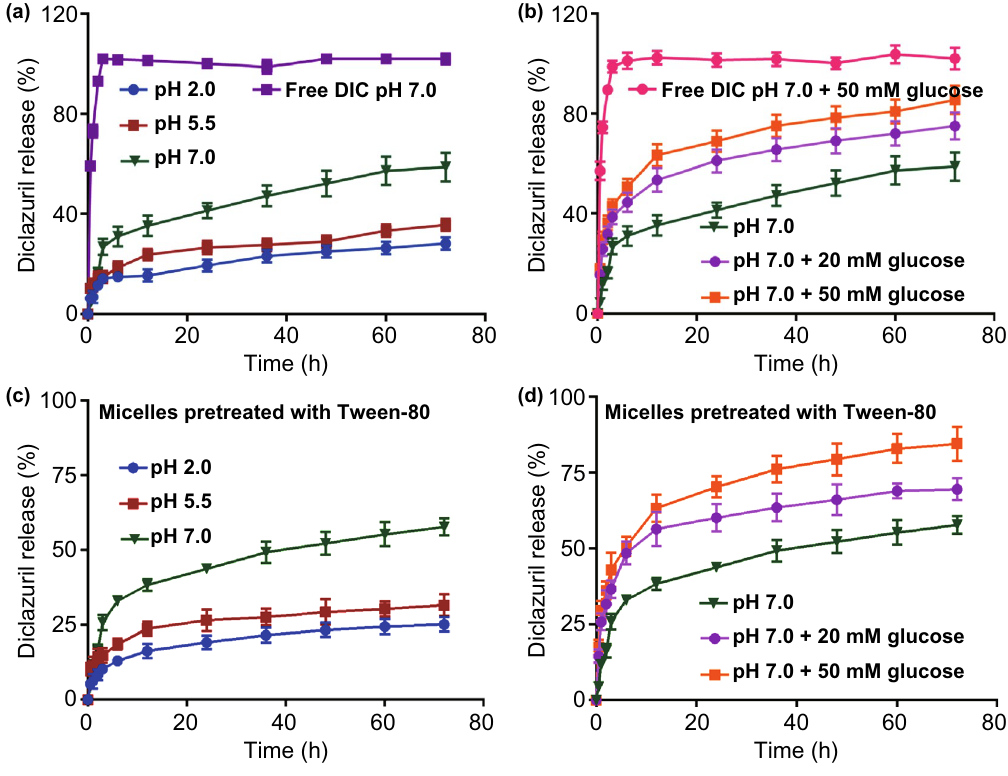
Figure 4 Stimuli-triggered drug release. a DIC release from SPCS/DIC micelles at different pH values of pH 2.0, pH 5.5 and pH 7.0. Free DIC release from dialysis bag at pH 7.0 was used as control. b DIC release profile from SPCS/DIC micelles in the presence of glucose at pH 7.0. Free DIC release from dialysis bag at pH 7.0 in the presence of 50 mM glucose was used as control. c SPCS/DIC micelle was preincubated with Tween 80 solution for 6 h and the DIC release profile at different pH values of pH 2.0, pH 5.5 and pH 7.0 was studied. d DIC release profile of the pretreated SPCS/DIC micelle in the presence of glucose at pH 7.0 was further studied. Data are expressed as mean ± SD, n =